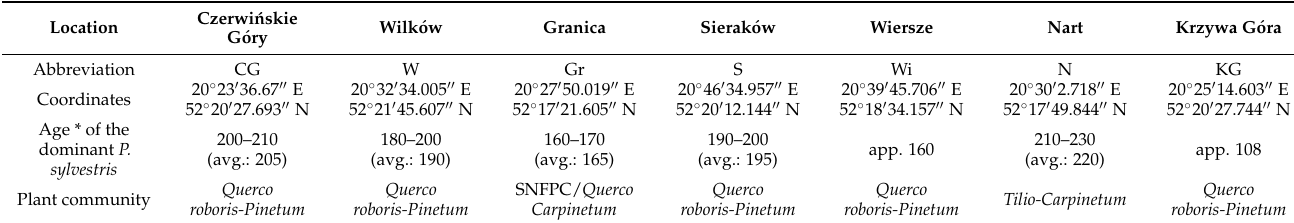
Table 1. The characteristics of the study locations.